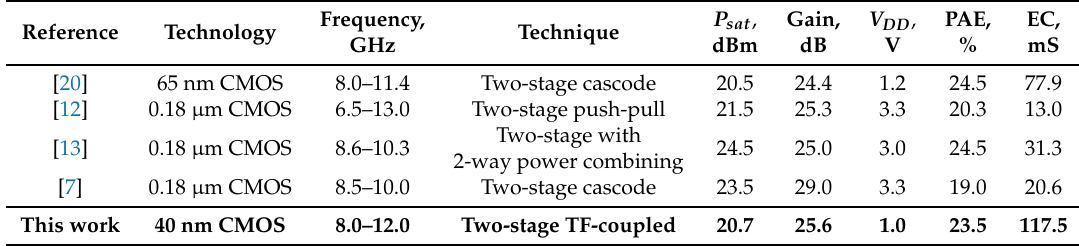
Figure 16. Measured maximum output power output (Pout), OP1dB, and peak PAE versus frequency. Table 2. Summary and comparison of proposed PA and previously published X-band CMOS PA with similar